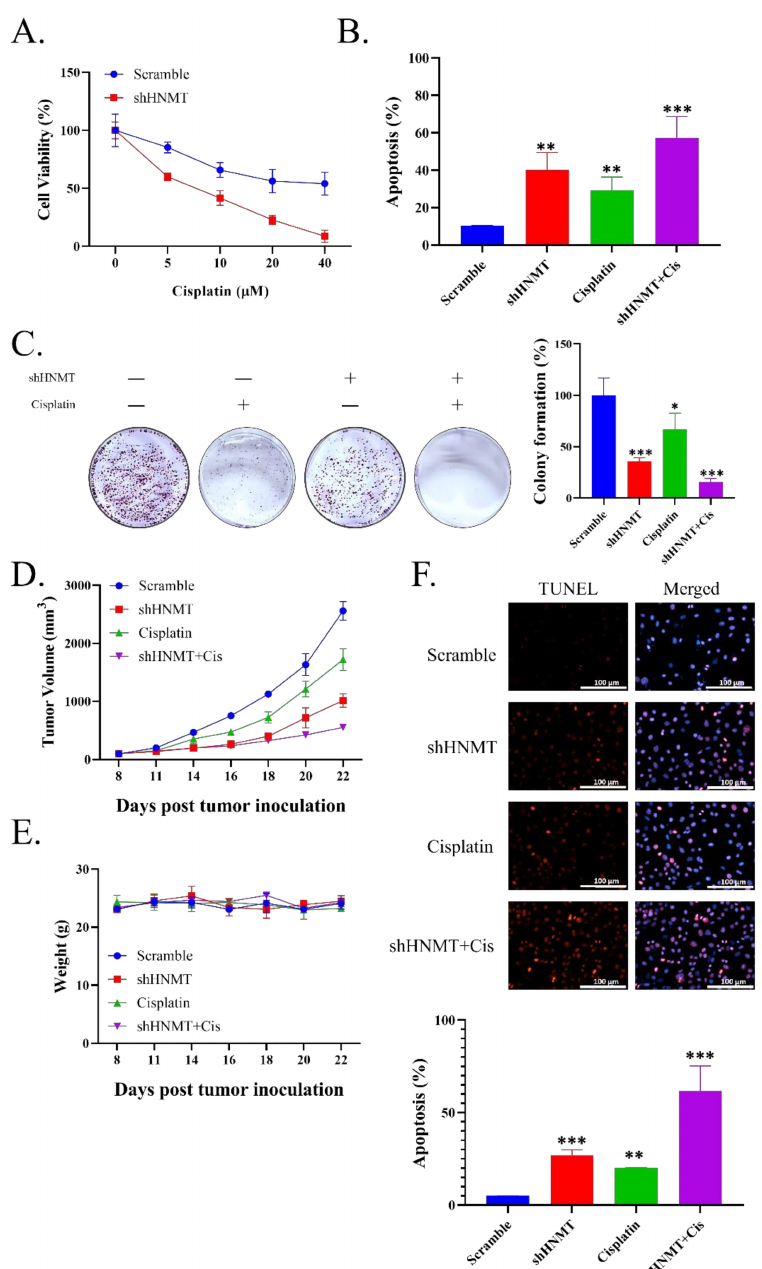
Figure 6. Association of HNMT with cisplatin resistance in lung cancer. ( A ) Cell viability (SRB) assay performed on A-549 cell line with or without shHNMT transfection followed closely by treatment with various dosages of cisplatin for 48 h. ( B ) Annexin V detection of apoptosis in H441 cells transfected with shScramble or shHNMT and incubated with or without 4 µ M cisplatin for 48 h. Live cells (lower left square), dead cells (upper left square), cells in early apoptosis (lower right square), and late apoptotic cells (upper right square). ( C ) Colony formation assay of H441 cells transfected with either shScramble or shHNMT and incubated with or without 1 µ M cisplatin for 10 days. Cells were then stained with crystal violet solution. ( D ) Tumor volume of mice xenografted with H441 cells with either shScramble or shHNMT was evaluated every 3 days after day 8 of tumor implantation to evaluate cisplatin treatment effectiveness. ( E ) Mouse body weight has been evaluated every 3 days. ( F ) Representative images of the TUNEL assay (red fluorescence for apoptotic cells and blue fluorescence for cell nuclei have been detected using a fluorescence microscope; magnification, 400 × ). The apoptosis rate is depicted in the bottom panel. * p < 0.05, ** p < 0.01, *** p < 0.001. Scale bar: 100 µ